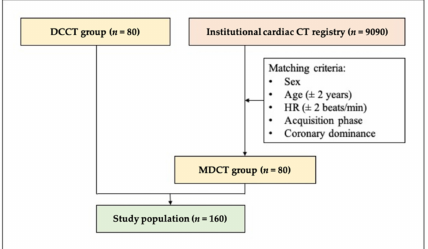
Figure 1. Flowchart describing the selection of the study cohort. DCCT, dedicated cardiac CT; HR, heart rate; MDCT, multidetector CT. All patients provided written informed consent prior